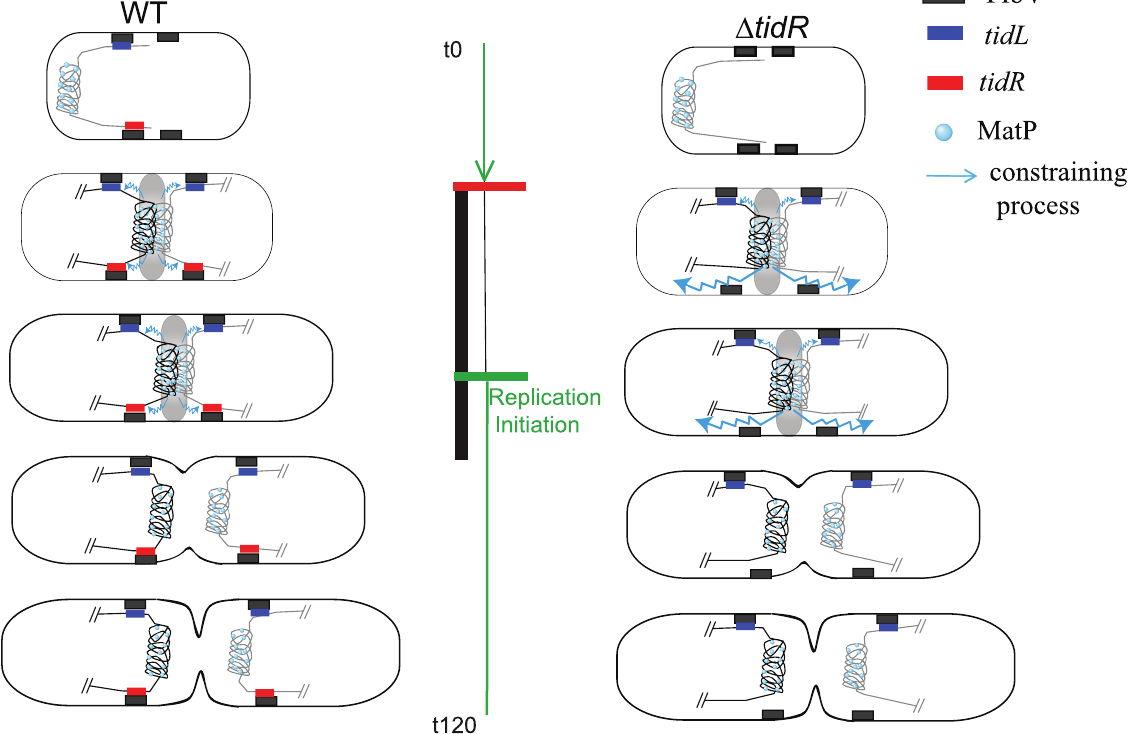
Figure 7. Model for the insulation of the Ter MD by tid RL. In wt cells (left panel), the Ter MD (only the Ter MD and the flanking DNA is represented) is found near the new pole. As the cell cycle progresses (see [13] for details), the Ter MD is segregated at mid-cell. Interaction of MatP with ZapB promotes the tight association of the Ter MD with the divisome (represented by a grey oval), period indicated by the vertical black bar. At this stage, the constraining process (schematized by a wavy blue line) is apparent but does not propagate behind tid R and tid L. The constraining process would abrogate when the Ter MD dissociates from the divisome. The insulation mechanism requires a direct or indirect association of tidR with YfbV. It is not known if this association lasts during the entire cell cycle. In D tid R cells (right panel), insulation is efficient only on the left arm of the chromosome and the constraining process spreads to the right arm of the chromosome. The replication period of wt cells is represented by the green vertical bar; replication is initiated in the mother cell (indicated by a green horizontal bar) and terminates soon after birth (indicated by a horizontal red bar).